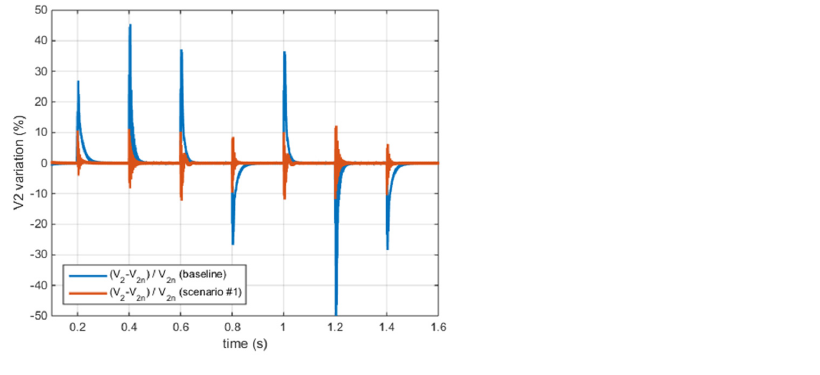
Figure 5. Grid voltage variation in the baseline scenario and Scenario #1 (SS − GN).